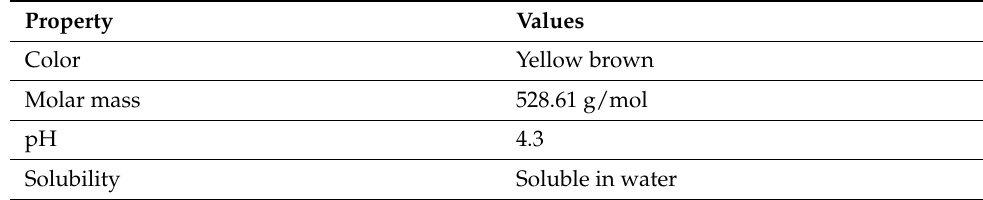
Table 3. Properties of